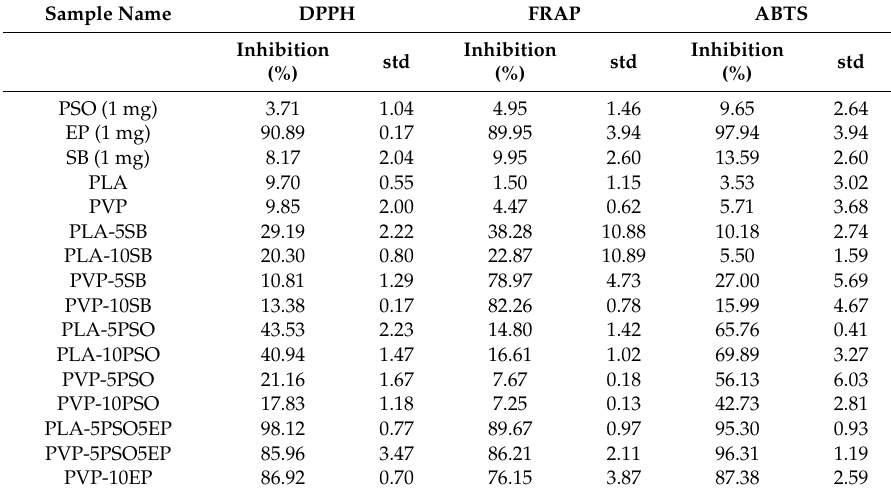
Table 5. Antioxidant Properties Determined by Di ff erent Assays. PSO: Pomegranate Seed Oil; EP: Ethanolic Extract of Fermented Pomegranate Juice; SB: Sea-buckthorn